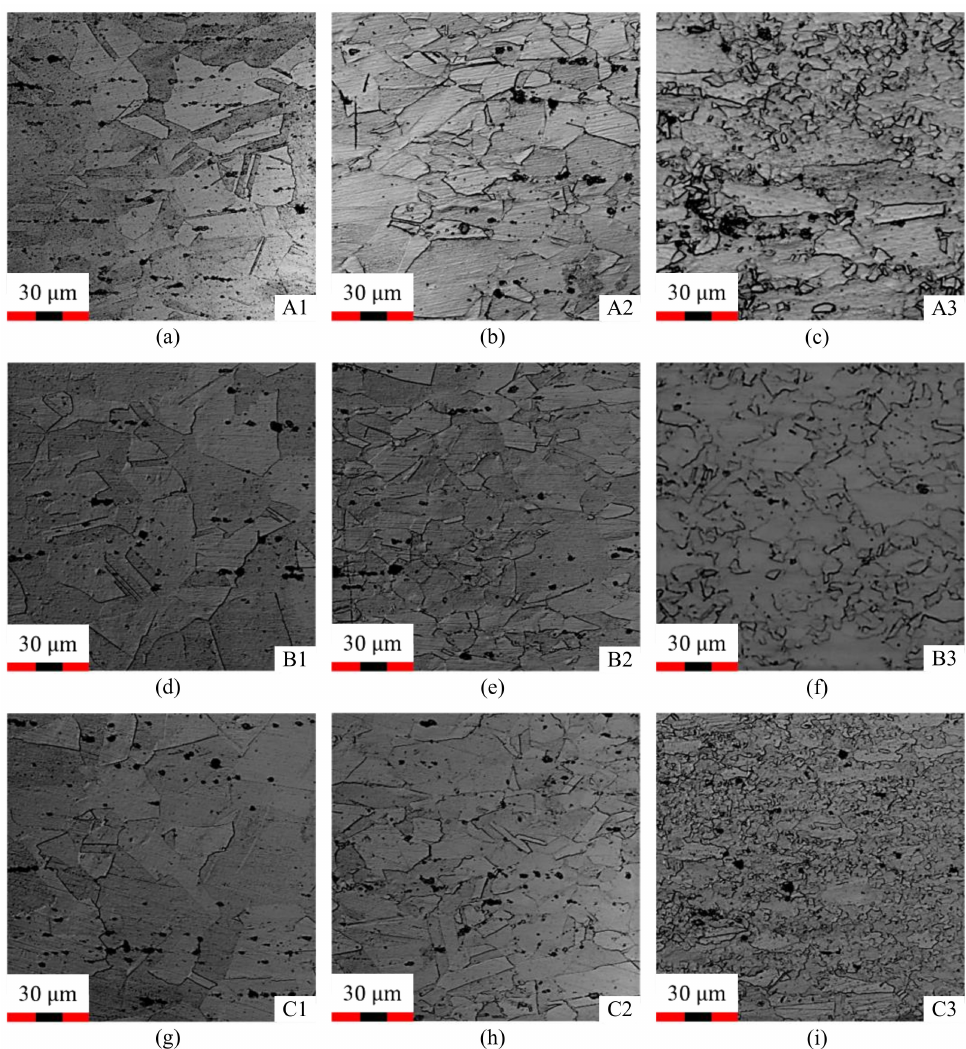
Figure 16. Grain morphologies at specified positions: ( a ) position A1; ( b ) position A2; ( c ) position A3; ( d ) position B1; ( e ) position B2; ( f ) position B3; ( g ) position C1; ( h ) position C2; ( i ) position